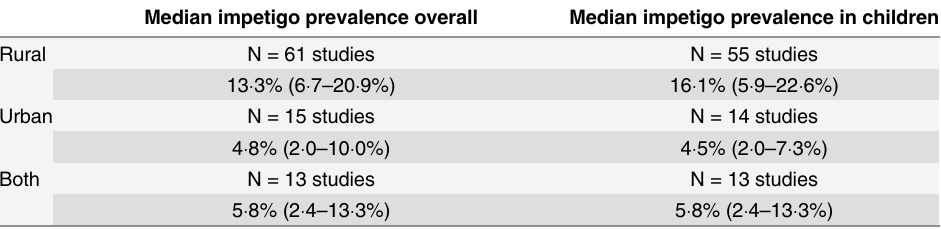
Table 6. Variability in median impetigo prevalence by urban and rural study